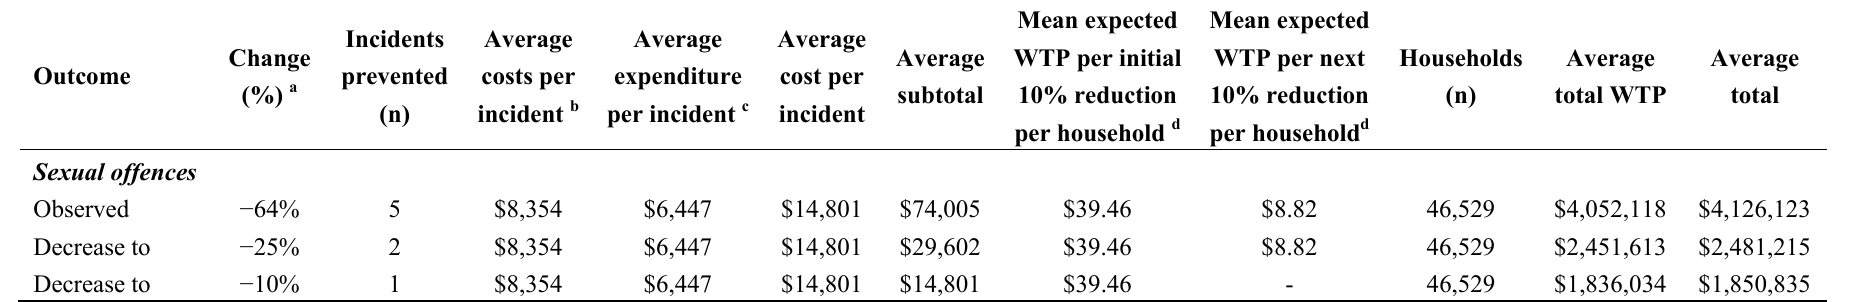
Table 4. Sensitivity analyses for the statistically significant reduction in alcohol-related sexual offences in the experimental, relative to control, communities (2008/2009 AUD